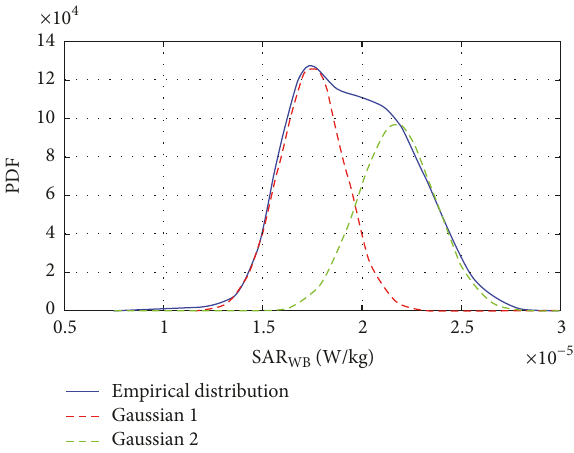
Figure 17: Fit of the SAR distribution with a Gaussian WB